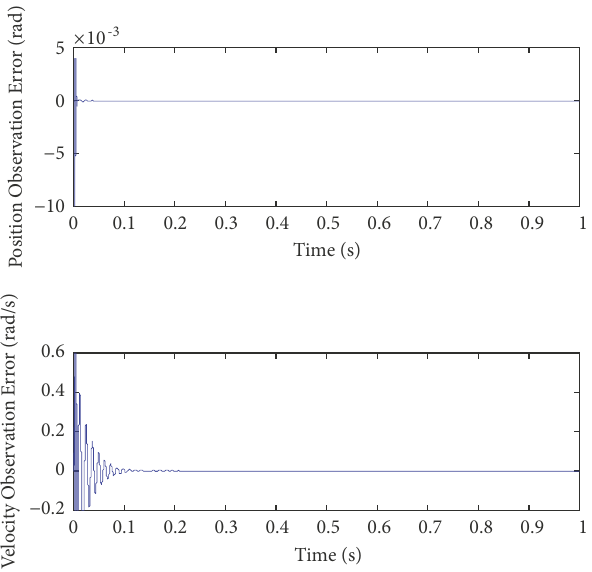
Figure 9: The estimation error of position and velocity of